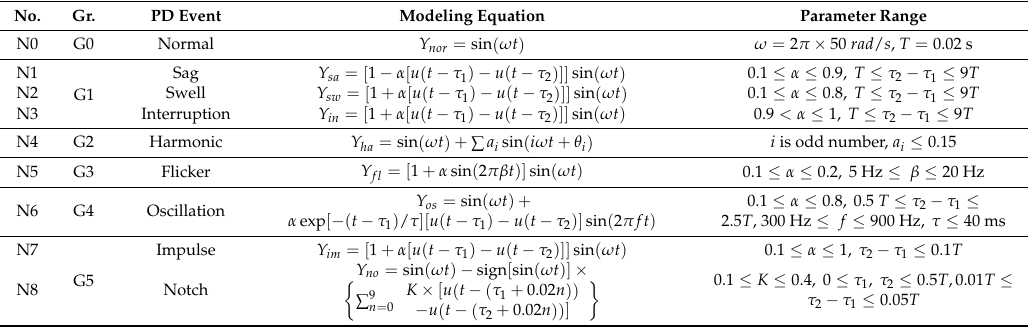
Table 2. Single power disturbance (SPD)